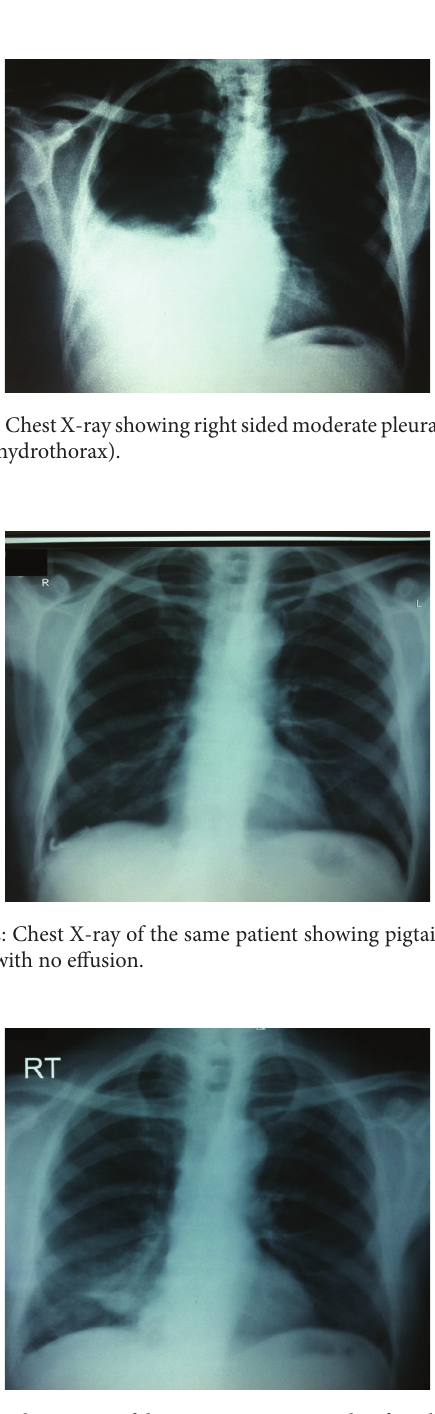
Figure3:ChestX-rayofthesamepatient2monthsafterpleurodesis and pigtail catheter removal showing no reaccumulation of fluid and successful